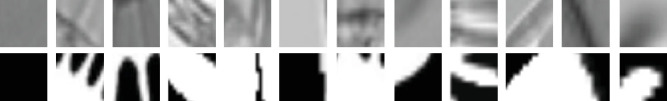
Examples of patches for patch-level training (the top row shows grayscale image patches, and the bottom row shows their corresponding GT images).